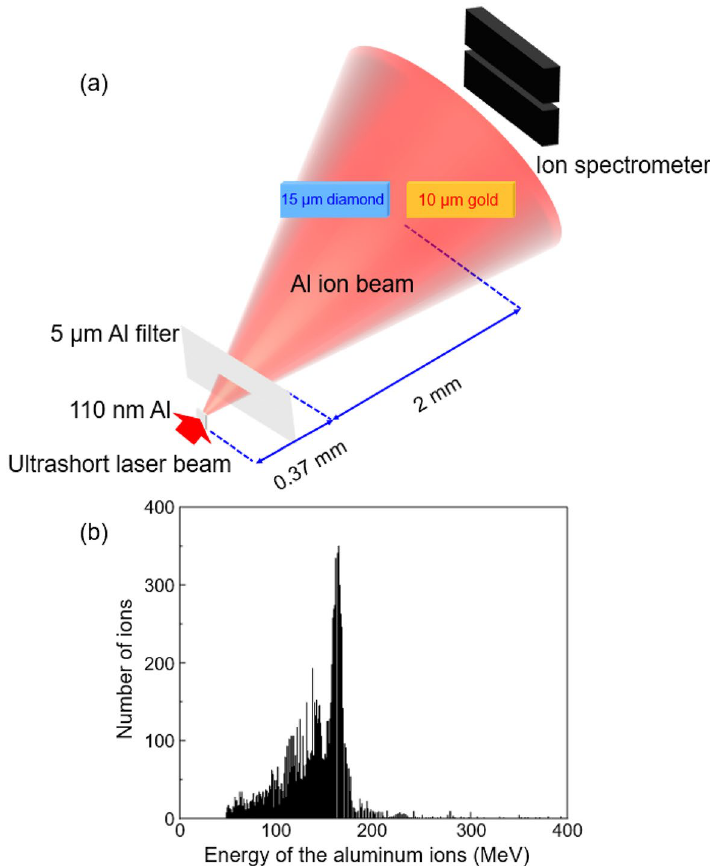
Figure 1. ( a ) A laser-driven aluminum ion beam with some energy spread impinges upon gold and diamond samples at a 45° incidence angle. The laser-driven aluminum beam heats gold and diamond samples isochorically. ( b ) Energy spectrum of the incident aluminum ions measured from Ref. 3 , which is used in our SRIM